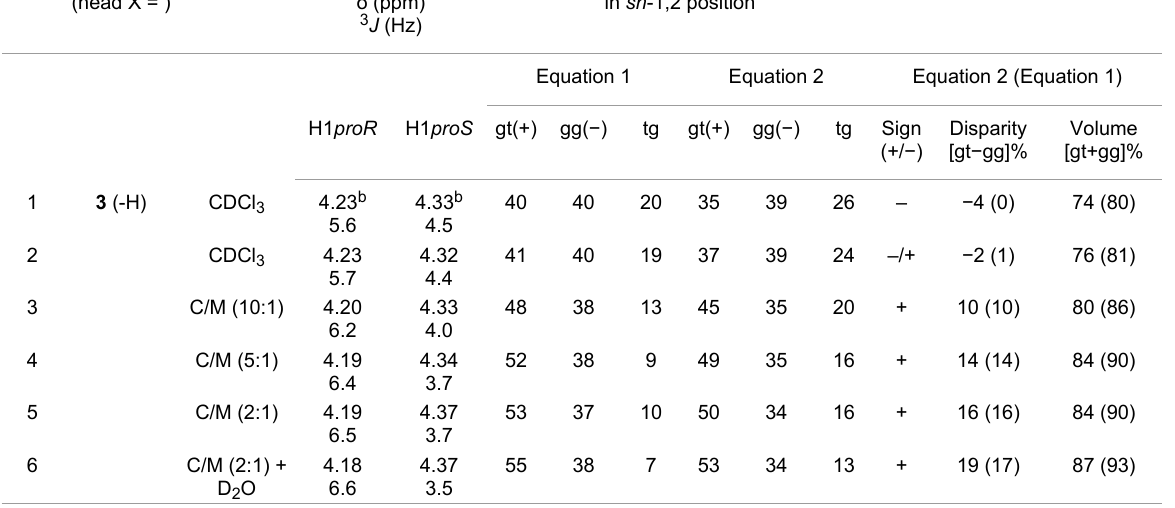
Table 2: 1 H NMR data and helical conformational properties of 1,2-dipalmitin 3 using different solvents. Entry Compound (head X = )